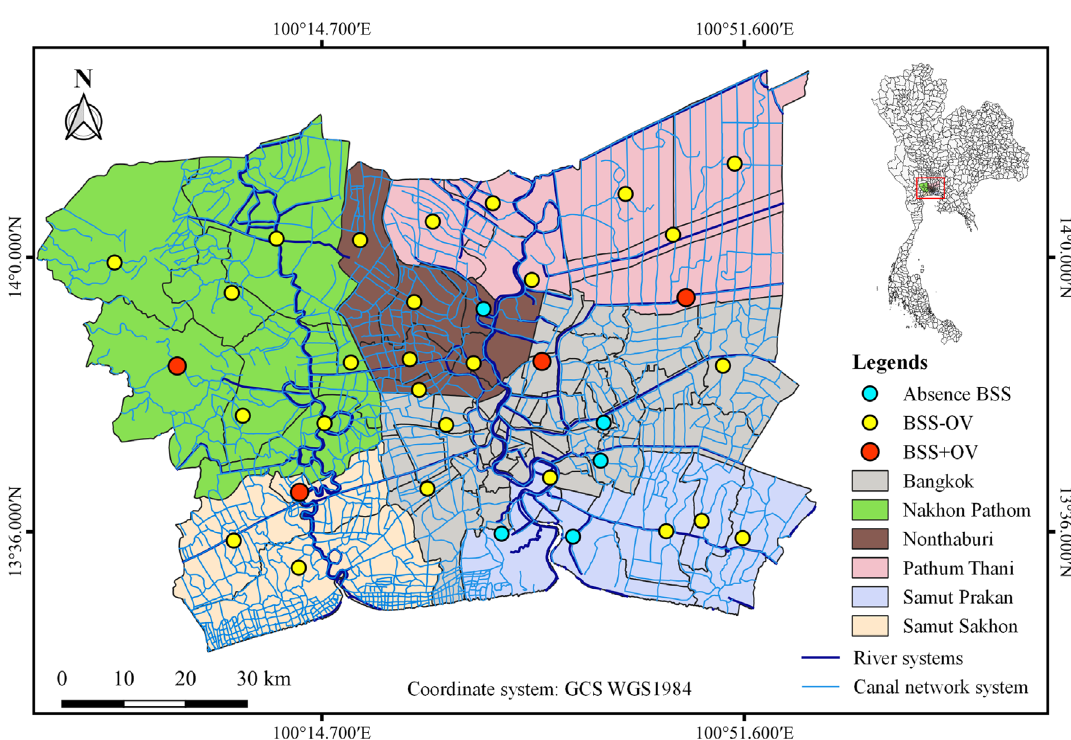
Figure 1. Map of study area in the Bangkok Metropolitan Region, Thailand. Sky blue spot, yellow spot, and red spot represent: (1) sampling locality without distribution of Bithynia siamensis siamensis snails, (2) sampling locality with B. s. siamensis distribution but no detected Opisthorchis viverrini s.l., and (3) locality with B. s. siamensis distribution and detected O. viverrini s.l.,